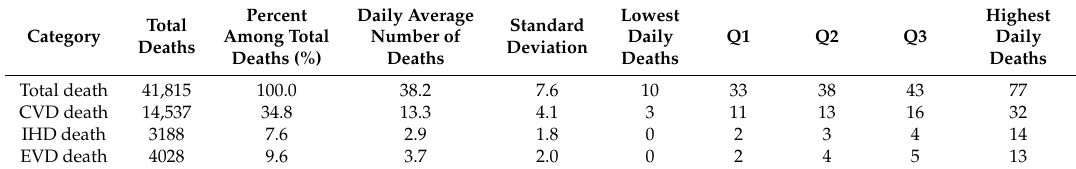
Table 1. Basic information of death residents from cardiovascular disease (CVD) in Shenzhen